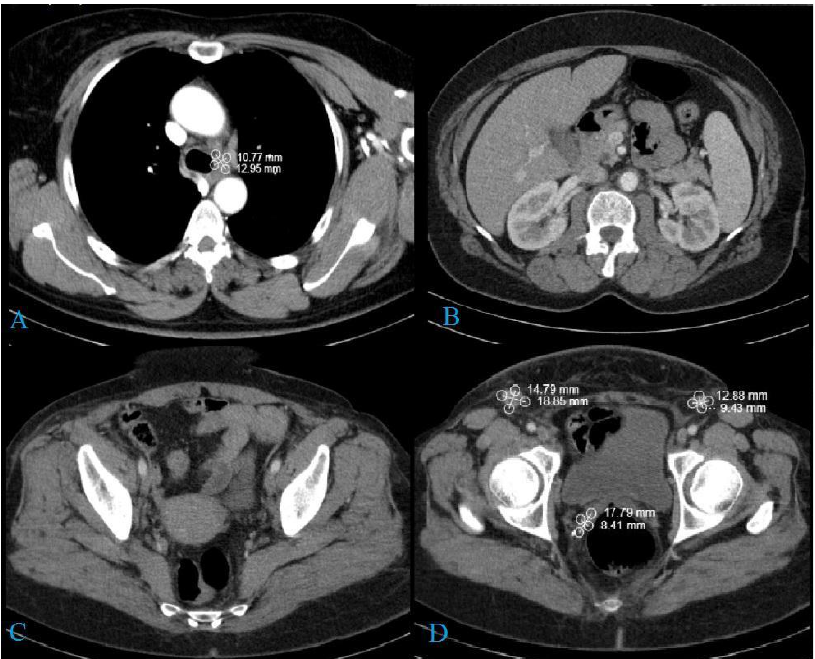
Figure 4. Histological findings of a metastatic inguinal lymph node: ( A ) carcinoma tissue with micropapillary growth pattern; ( B ) p63—positive in 80–90% of tumor the cells.